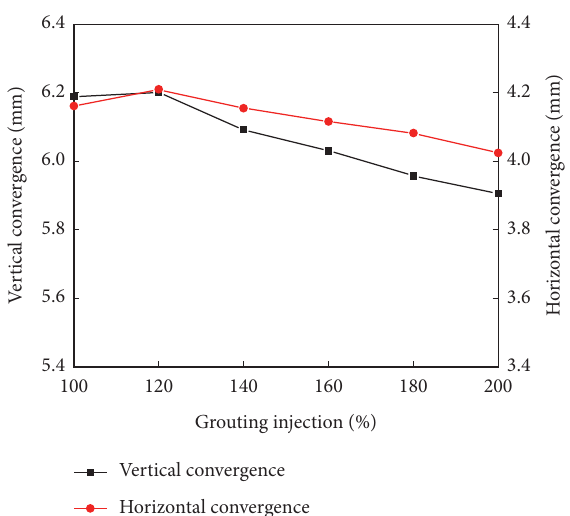
Figure 15: Variation of the convergence value of the segment under different grout injection rate